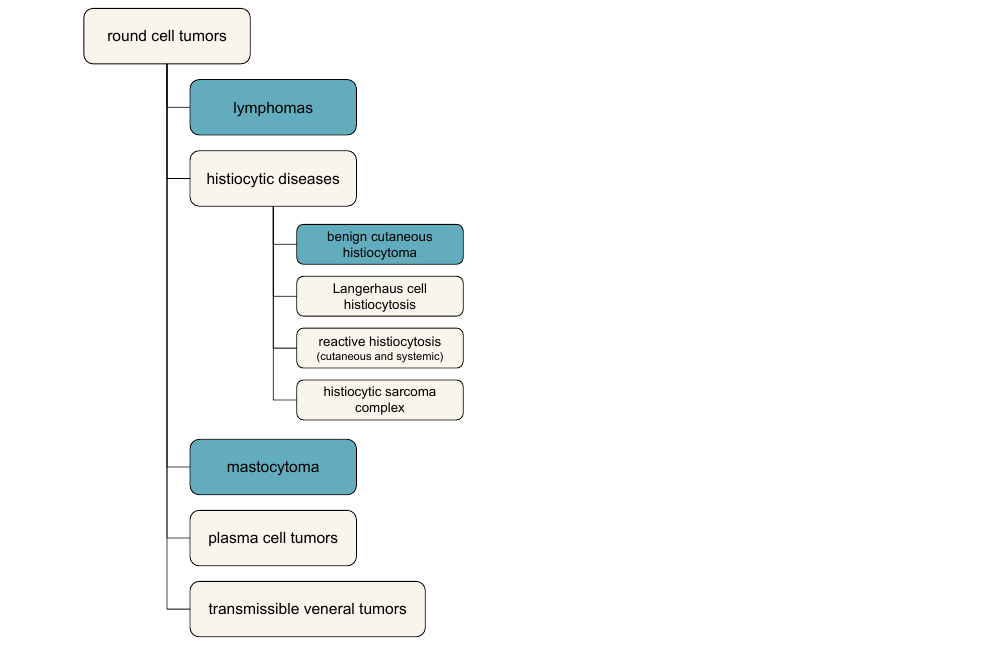
Figure 2. Round cell tumors classification based on [11]. Three classes represented in our dataset are highlighted.